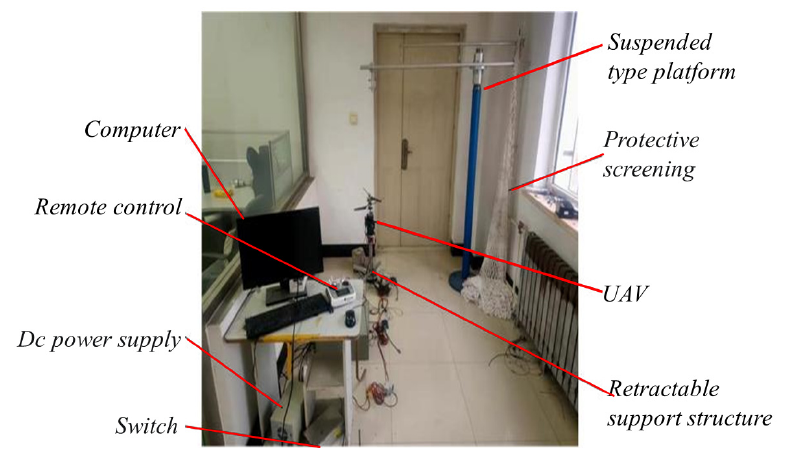
Figure 5. Static test platform diagram of the coaxial twin-rotor.